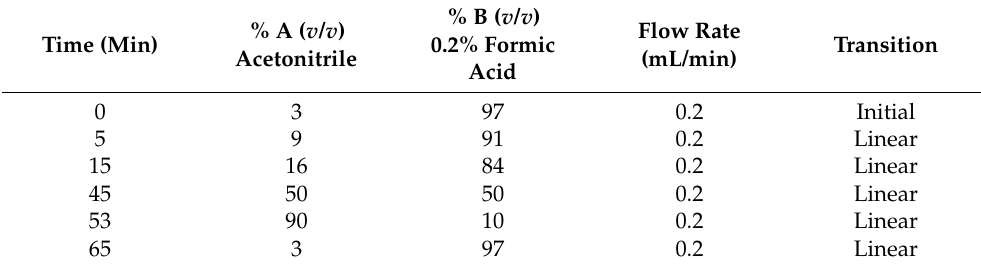
(Table 3). Samples were filtered using ThermoScientific 0.22 µ m nylon filters. Sample injection volume was 5 µ L. Mobile flow rate was kept at 0.2 mL/min, operation pressure: 160–170 atm. Table 3. Gradient conditions for the HPLC-MS analysis of the extracts. % B ( v/v ) % A ( v/v ) Time (Min) 0.2% Acetonitrile